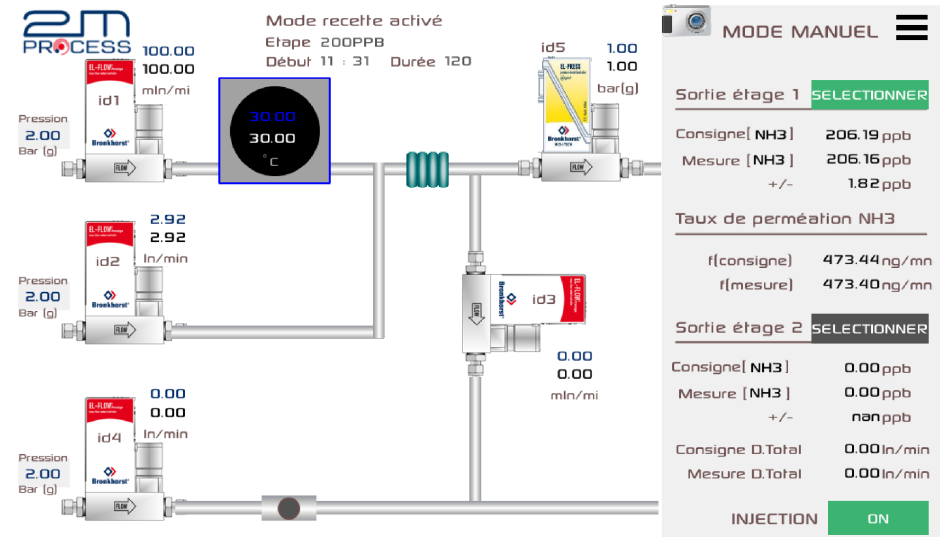
Figure 3. Schematic diagram of the reference generator. The mass flow controllers (MFCs) used to regulate the carrier and dilution gas are indicated as id1–id4. The label id5 represents the pressure controller, and the blue square is the oven where the permeation tube is placed. On the right side of the figure, an example of the set and reading values provided by the software is shown (the graphical user interface is in